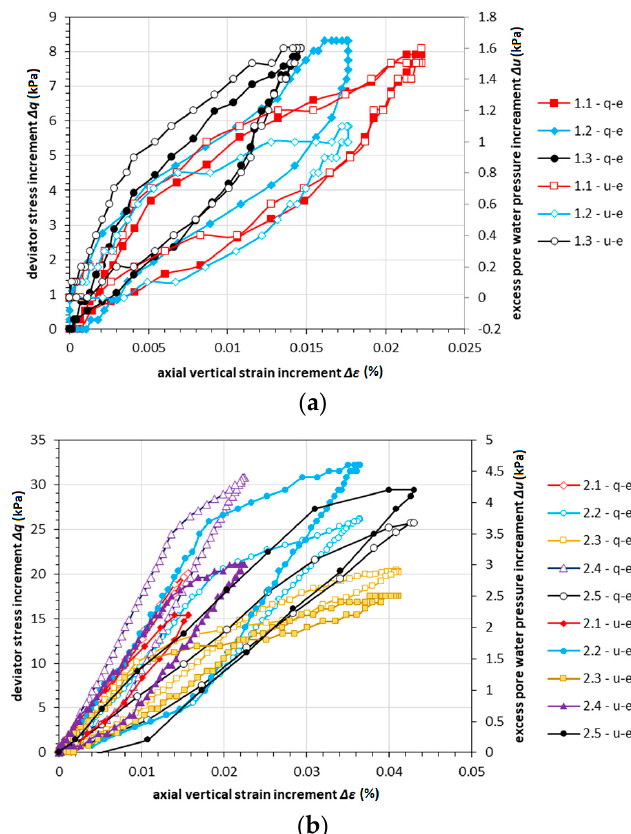
Figure 11. Excess pore pressure and deviator stress versus axial strain for the last cycle of loading from the triaxial tests: ( a ) Isotropically consolidated samples, and ( b ) K 0 -consolidated samples. For K 0 -consolidated samples’ Δ u / q max ratio had a linear relationship with q m / q a , which indicates that the excess pore water pressure value in one cycle impacted the deviator stress characteristics.